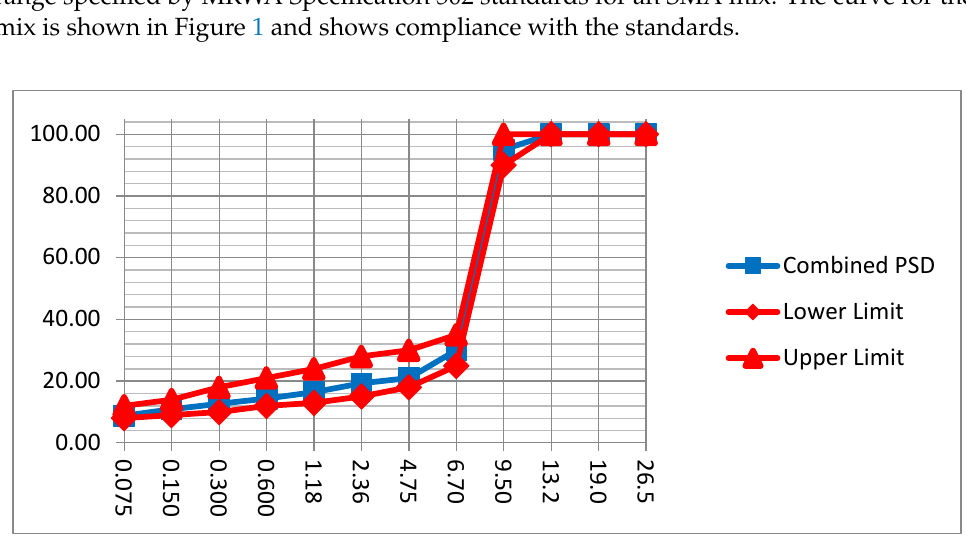
Table 7. Final mix design. Material